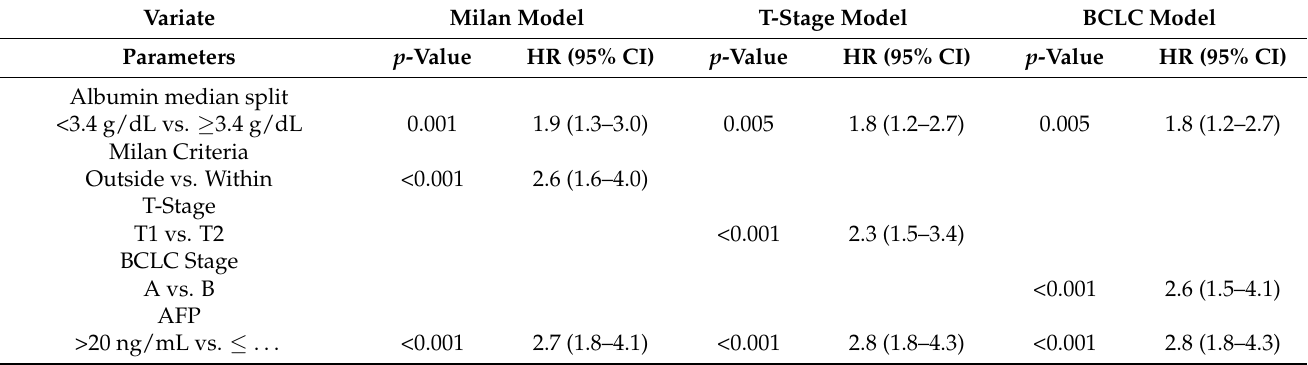
Table 3. Multivariate analysis of time to progression by albumin median split.